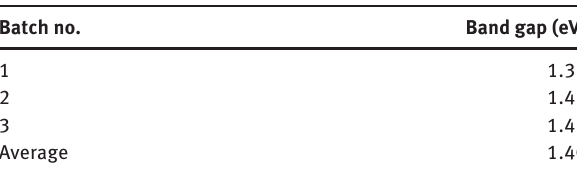
Table 2: Relative elemental ratios of the synthesized sample as detected by EDX